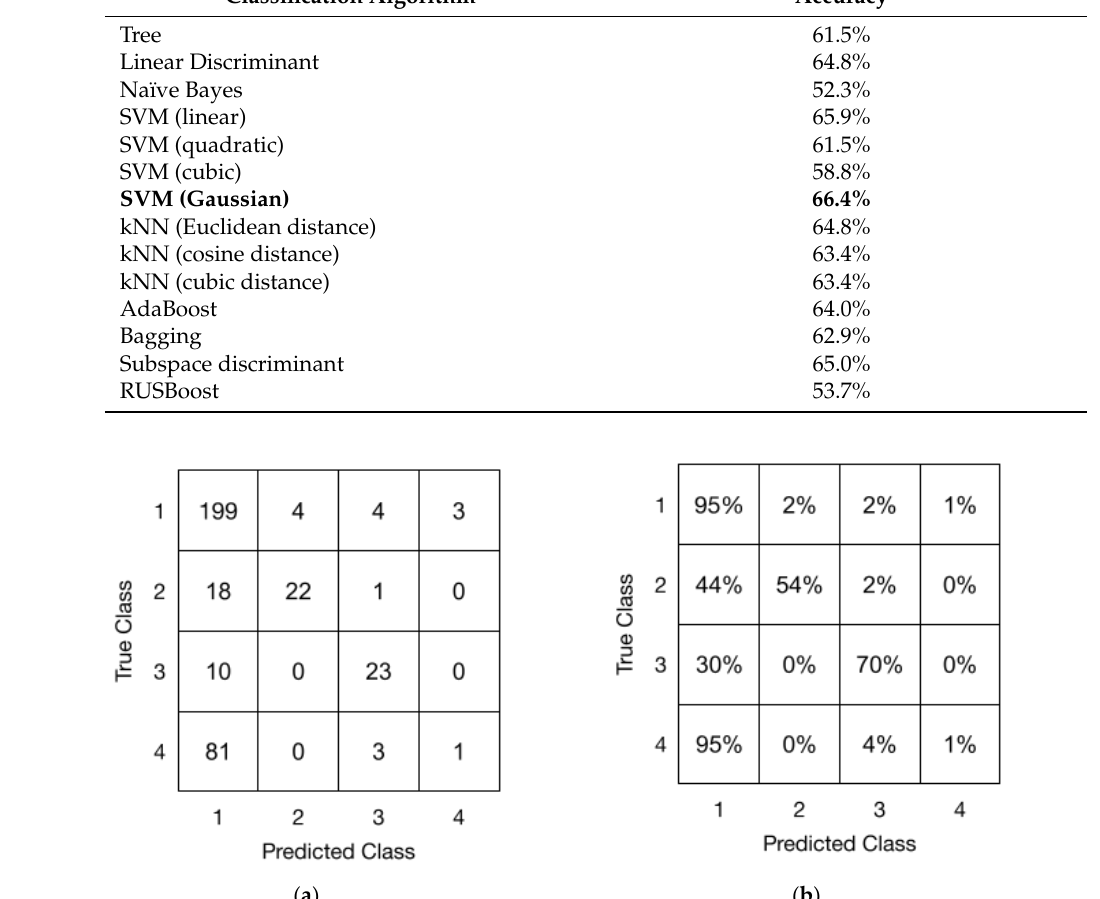
Figure 4. Confusion matrix of the classification algorithm with the best accuracy (SVM with Gauss- ian kernel). Class 1, cable insulation failure; Class 2, excavation damage; Class 3, secondary substation busbar; Class 4, cable joints failure. ( a ) Numerical values; ( b ) percentages considering the elements in each true class.